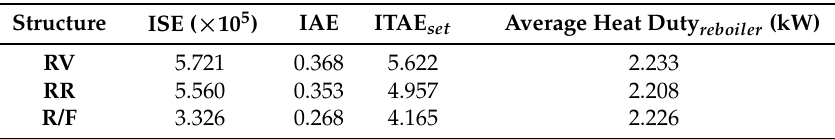
Table 10. Performance indicators of control structures—case of simultaneous feed composition and feed flux rate sinusoidal